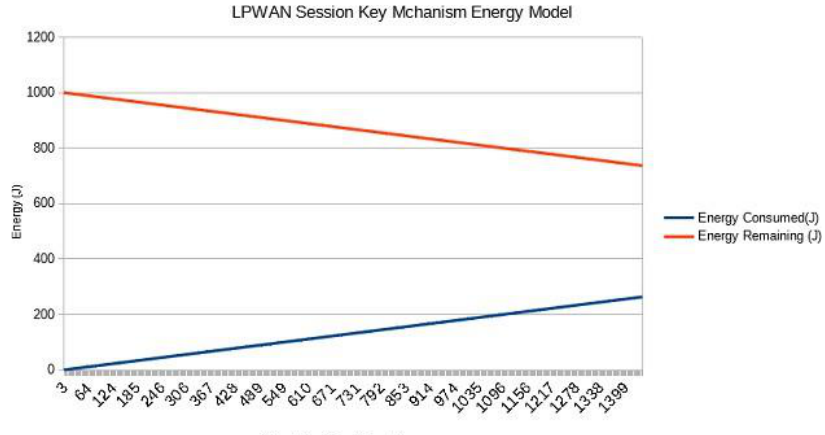
Figure 6. Energy Consumption of the LPWAN Session Key Mechanism.